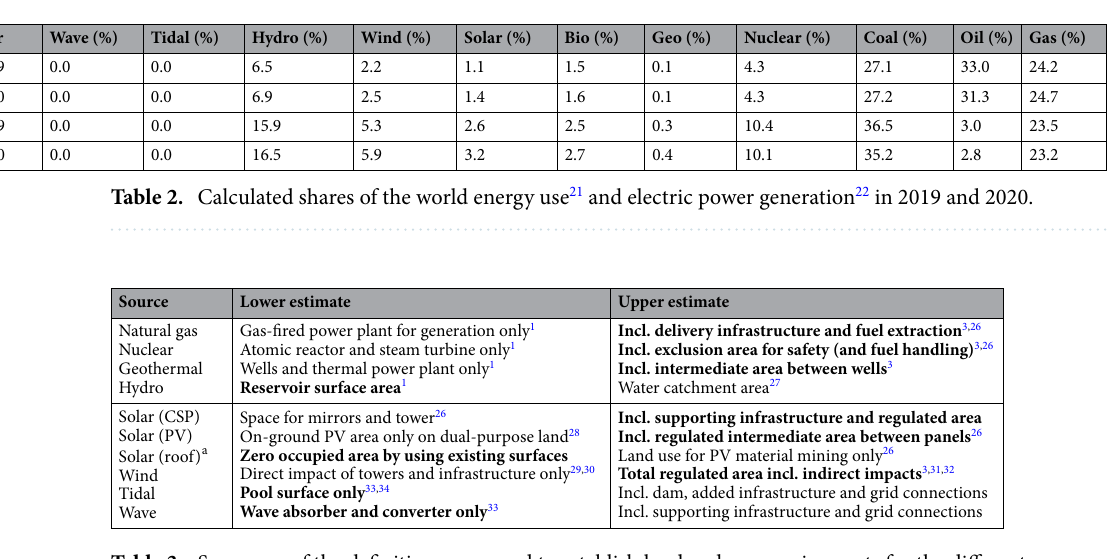
Table 3. Summary of the definitions proposed to establish land and sea requirements for the different power sources and technologies with references to existing studies in the literature, providing a comparison between lower and upper estimates. The bold values indicate the land use definitions considered in this paper. a Even though the land use for rooftop solar PV is low via the utilization of existing surfaces, the energy density of the actual surface must still be used to evaluate the scalability of residential distributed